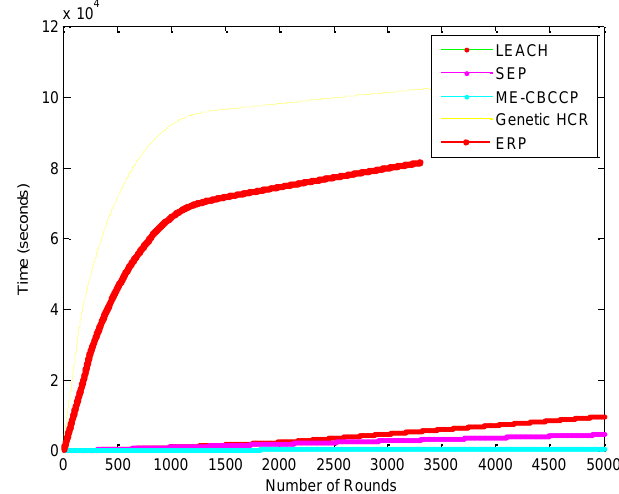
Figure 7. Transmission delay (I) (1000 nodes, 200 m 2